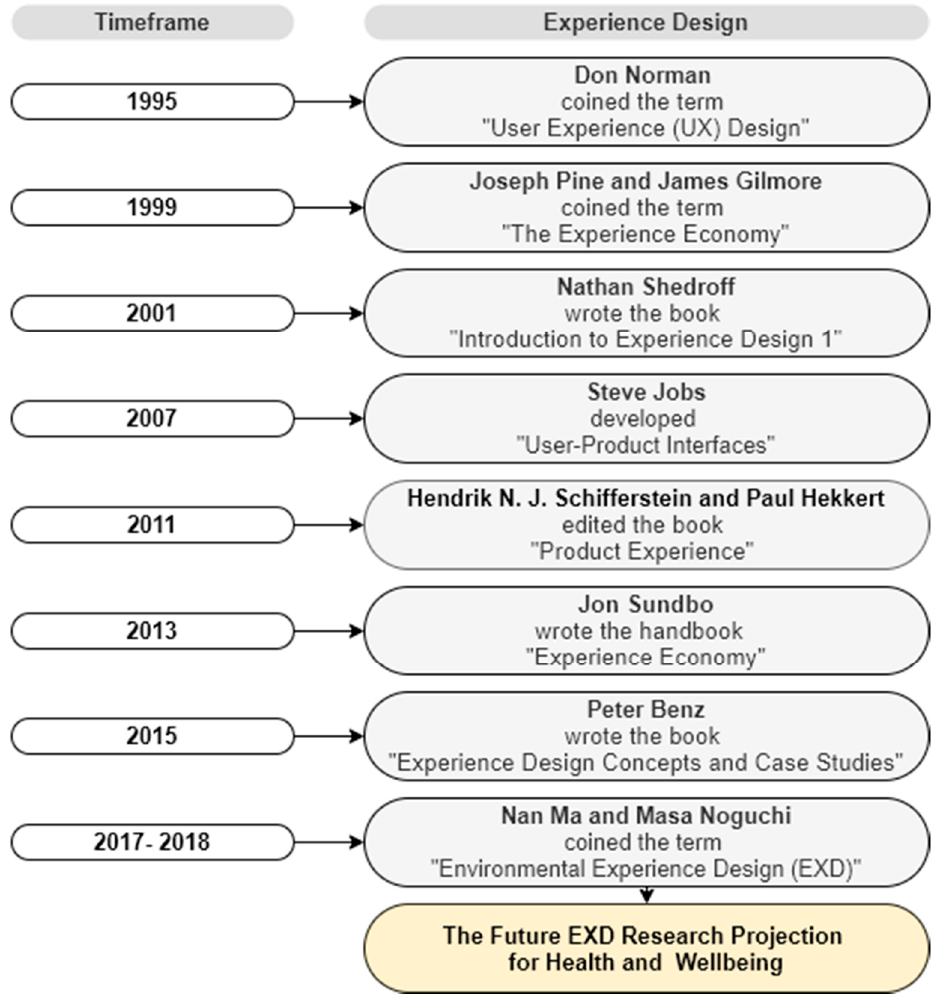
Figure 11. Historical milestones of user experience design initiatives and the future direction.